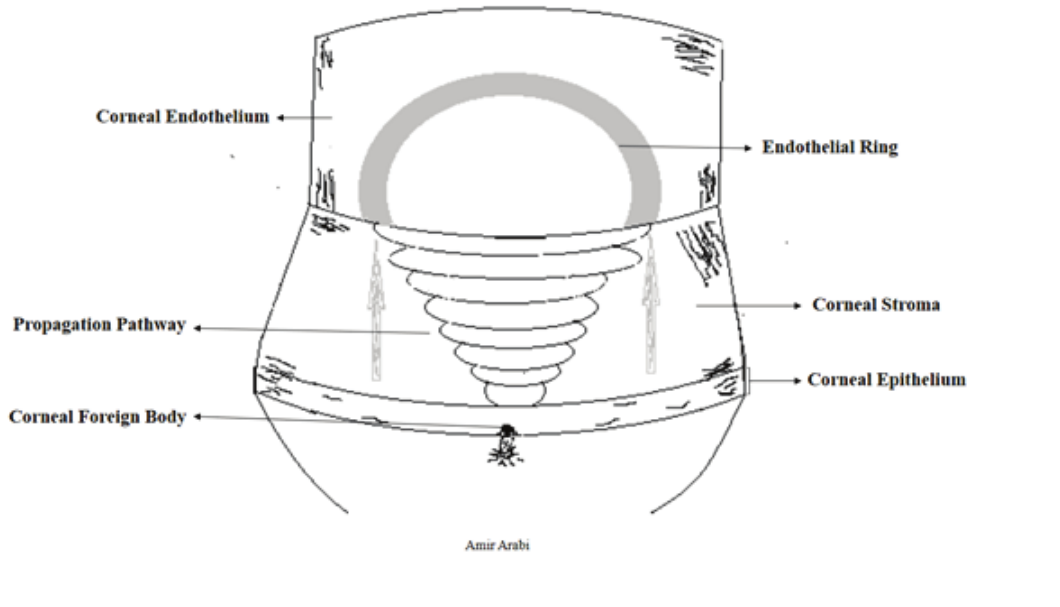
Figure 3. A schematic view for propagation of the force from corneal epithelial surface to the endothelial